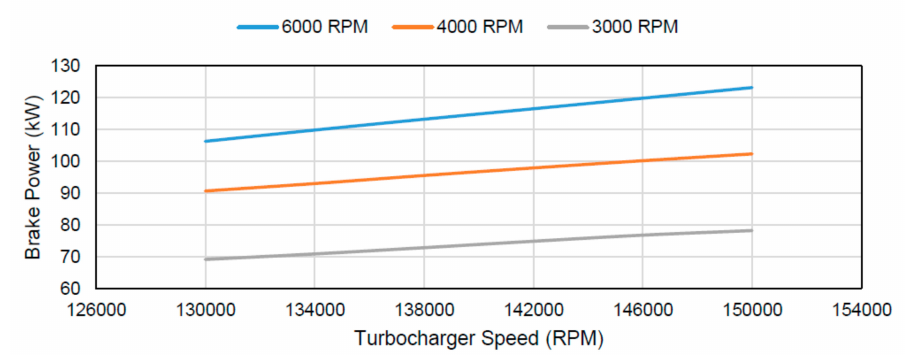
Figure 11. Variation of engine torque during compressor speed sweep at di ff erent engine speeds.